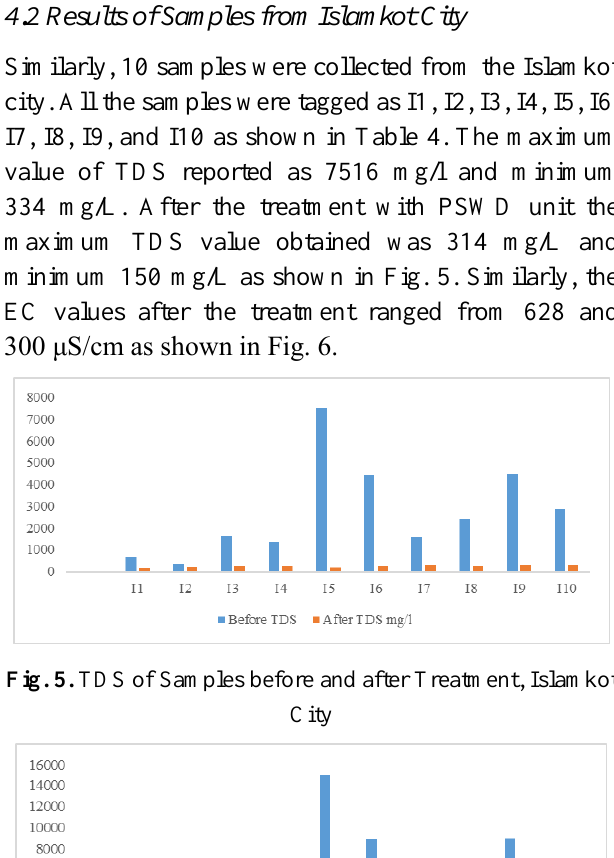
Fig. 4. EC of Samples before and after Treatment, Mithi City